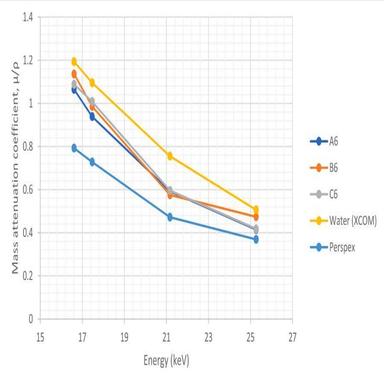
The mass attenuation coefficients of Rhizophora spp. particleboards with 6% adhesive in comparison with water (XCOM) and Perspex ® at energy range of 16.62–25.27 keV.